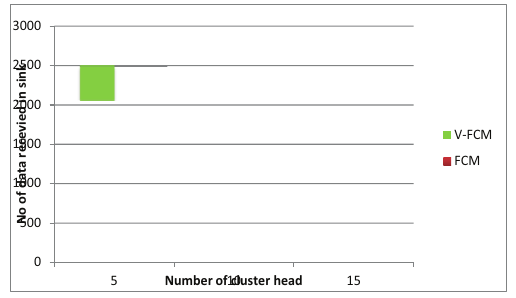
Fig: 8 size of data received data in sink node Vs No of cluster